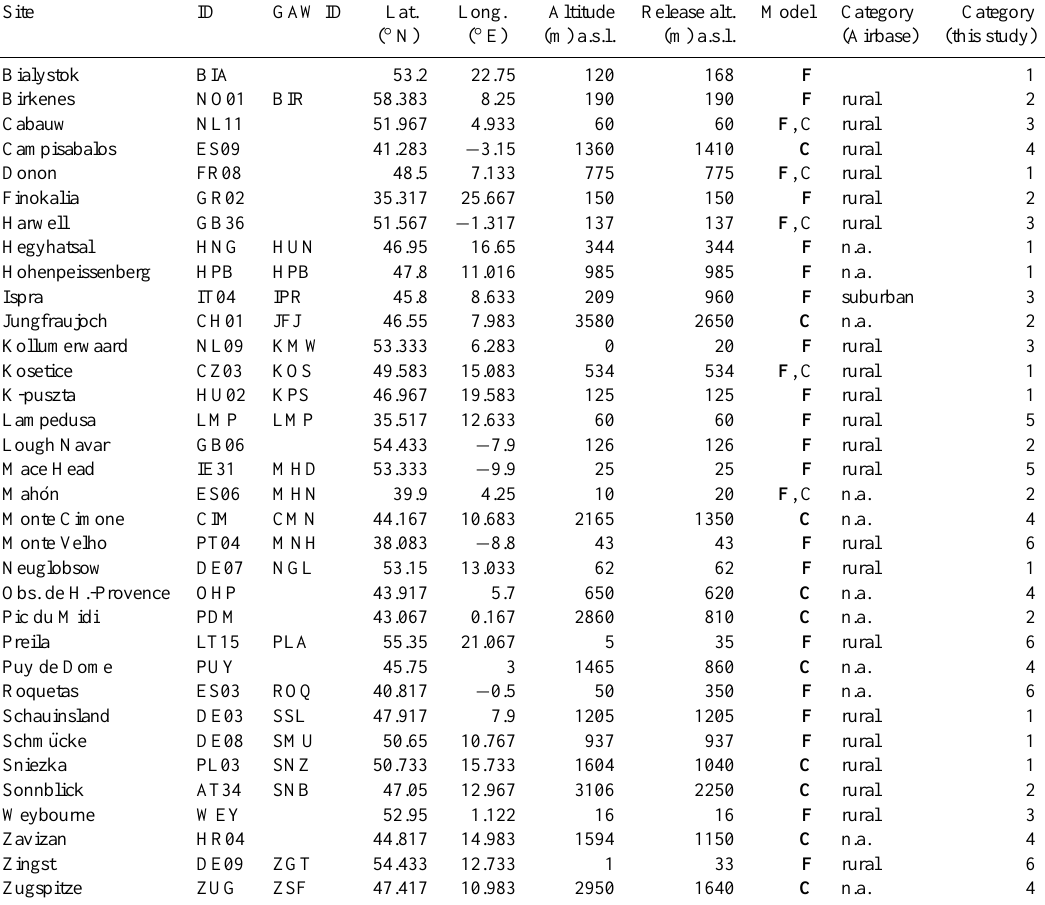
Table 1. Selected sites for detailed assessment of representativeness. In the column Model F stands for FLEXPART and C for COSMO LPDM, a bold letter indicates which model was used for deriving the catchment area of the site. The station categories derived for this study are: (1) rural , (2) mostly remote , (3) agglomeration , (4) weakly influenced, constant deposition , (5) generally remote , (6) weakly influenced, variable deposition . For sites with Airbase category n.a. no category was